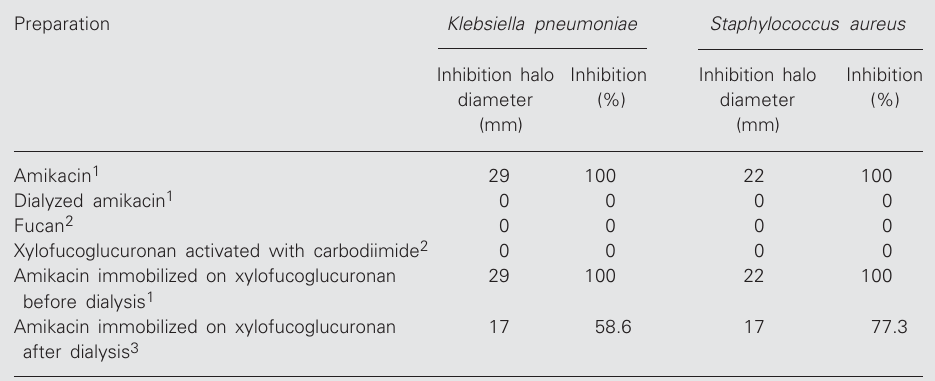
Table 2. Sensitivity of Klebsiella pneumoniae and Staphylococcus aureus to amikacin immobilized on xylofucoglucuronan.